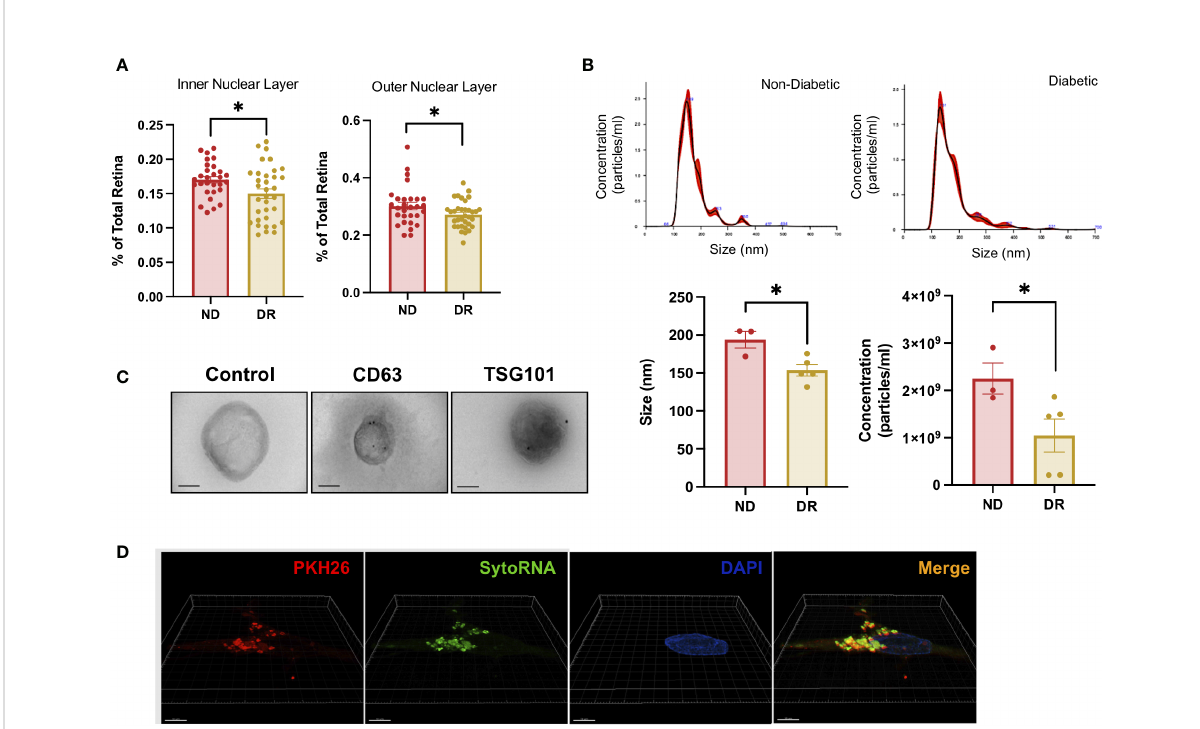
FIGURE 1 Diabetic Retinopathy and Non-Diabetic Human Retina EV release rate, characterization, and genetic transfer. (A) Retinal outer nuclear layer (ONL) and inner nuclear layer (INL) percent thickness were compared between DR and non-Diabetic retina ex vivo . Mean ± S.E.M.; *p< 0.05 Student´s t-test. (B) Particle size distribution in non-diabetic and diabetic retina (upper panels) and concentration and size (lower panels) were measured in triplicates. Mean ± S.E.M.; *p < 0.05 Student´s t-test. (C) TEM imaging of EVs isolated from human diabetic retina conditioned media from left to right Negative stain control, CD63 and TSG 101 staining. Scale Bar= 100nm. (D) Representative images of Lipid membrane and RNA labeled EVs uptake by unlabeled retinal cells. Super-resolution microscopy was used to visualize RNA (SytoRNA/green) and lipid membrane (PKH26/red) labeled EVs released from adult retina and taken up by control non-labeled adult retinal cells in a transfer